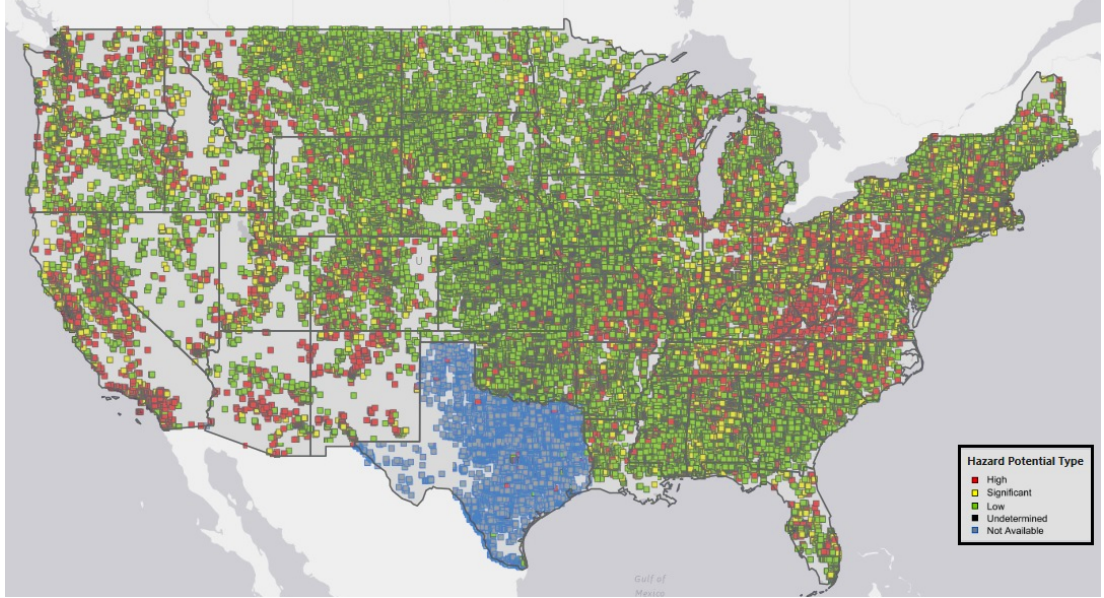
Figure 2. Distribution of dams with potential hazard type in the United States as of 2020; Generated from NID